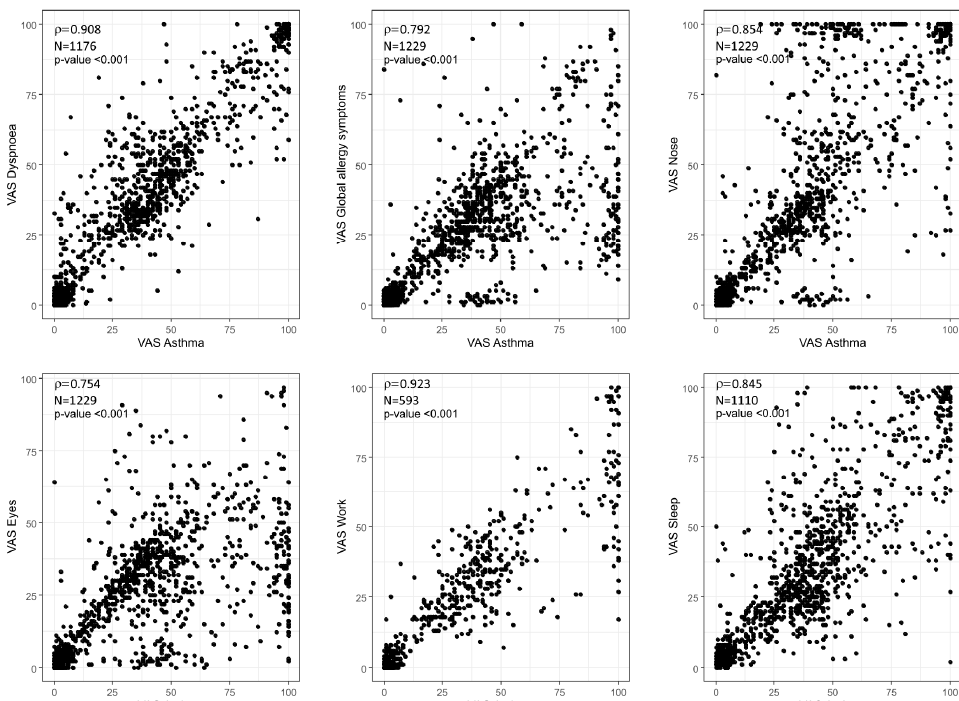
Figure 4. Correlations between different visual analogue scales (VAS) and the VAS assessing the severity of asthma symptoms (“VAS Asthma”) (Spearman’s rank correlation). N: number of observations; ρ = Spearman’s rank correlation coefficient